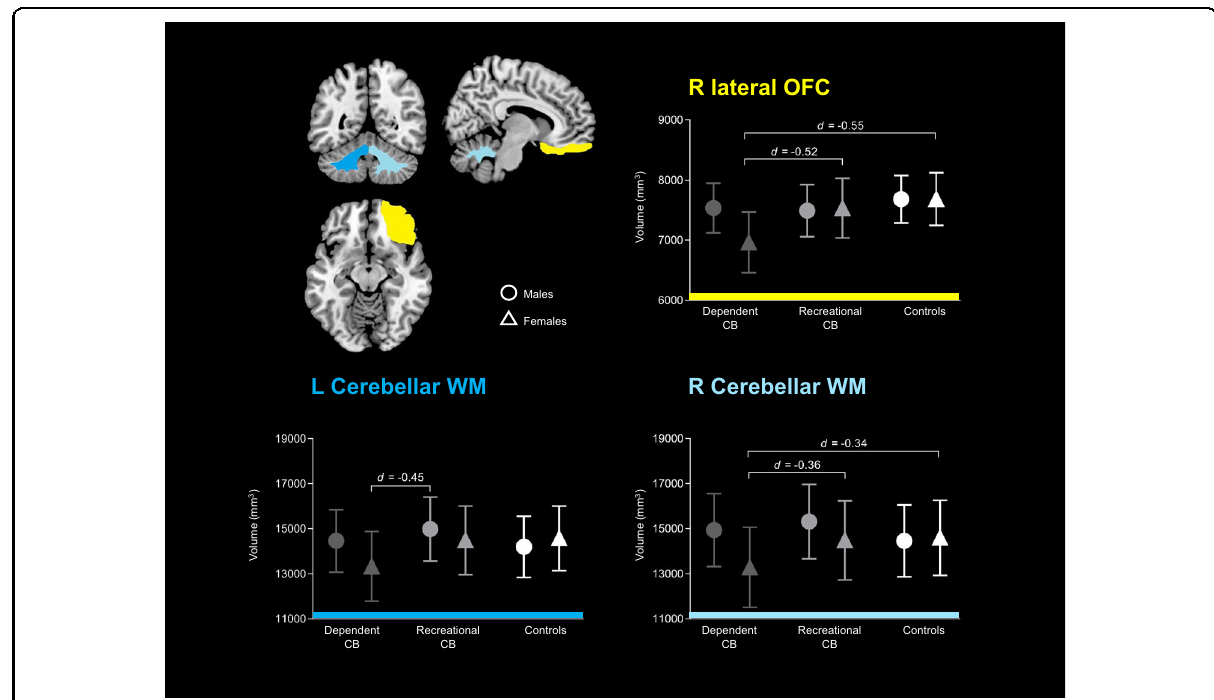
Fig. 1 Predicted cerebellar white matter (WM) and right lateral orbitofrontal cortex (OFC) volumes in cannabis users (CB) with and without dependence and controls. Vertical and horizontal bars represent 95% con fi dence interval and group-by-sex effects,